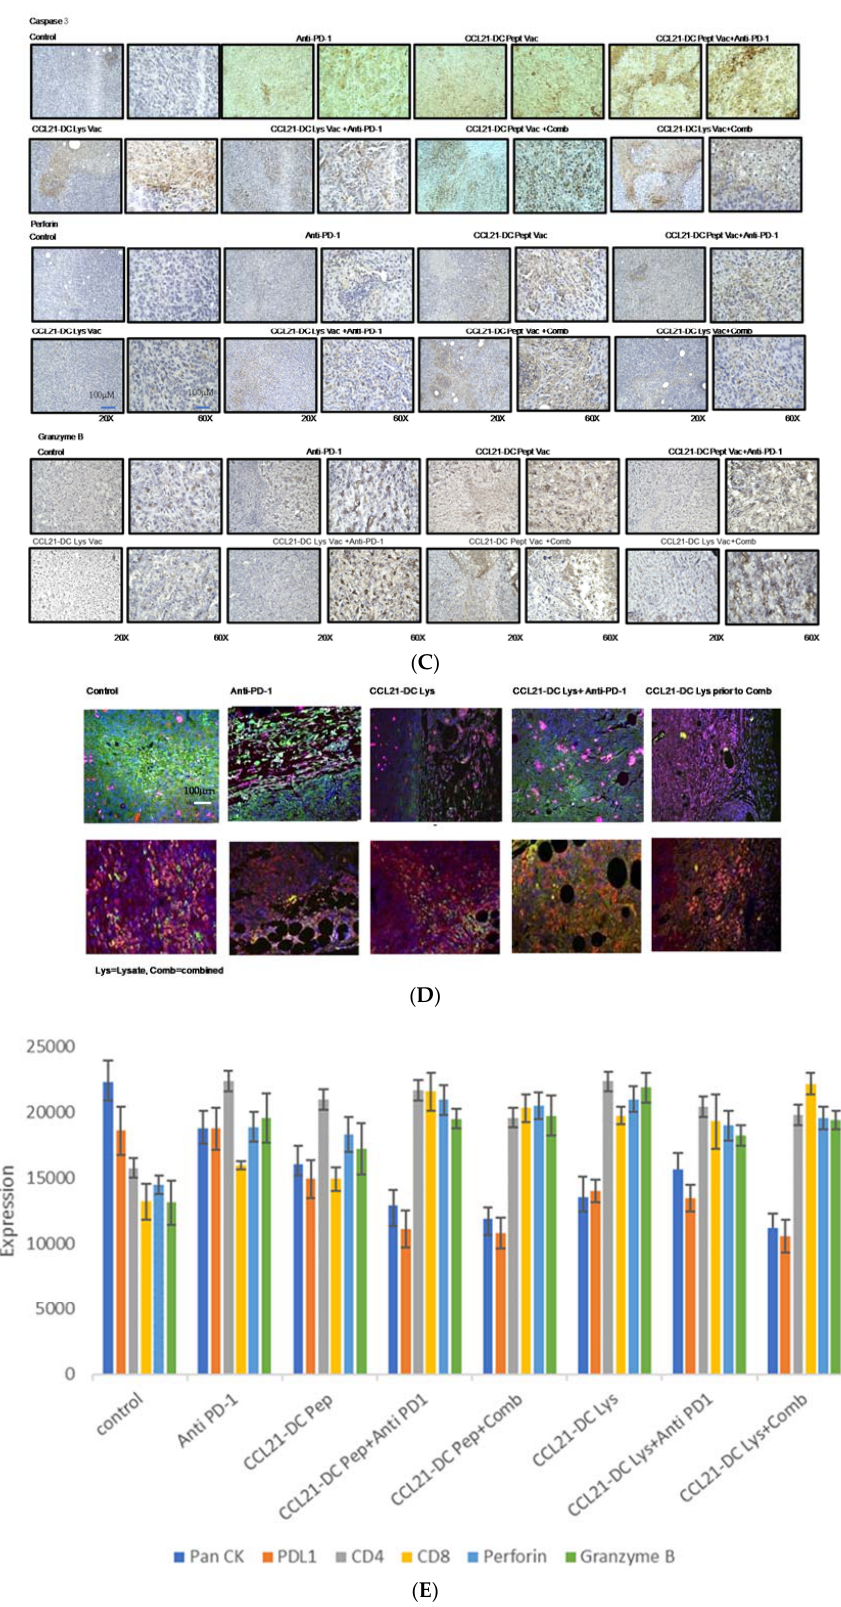
Figure 2. Combined Therapy Enhances CD8 T cells Expressing Perforin, TIL Cytolysis Immune Infiltrates and Reduced Tumor Burden ( A–E ). Table 2. Table 1 LKR-13 cells (10 6 ) were inoculated by s.c. injection in to 129-E strain of mice. 12-days